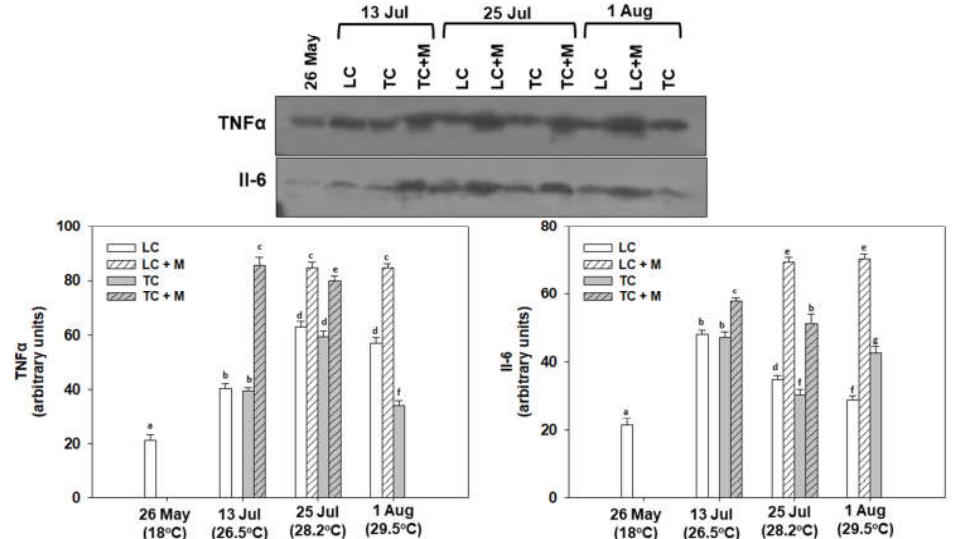
Figure 11. TNF α and Il-6 levels in the mantle of M. galloprovincialis specimens, either infected by Martelia spp. (M) or not. Samples were collected from Thermaikos Gulf during a summer heatwave both from traditional culture-Bouchot (TC) and long-line system (LC). Representative blots are shown. Values represent means ± SD; n = 5 preparations from different animals. Lower case letters indicate statistically significant differences ( p < 0.05) between samples. Original blots: Figures S4